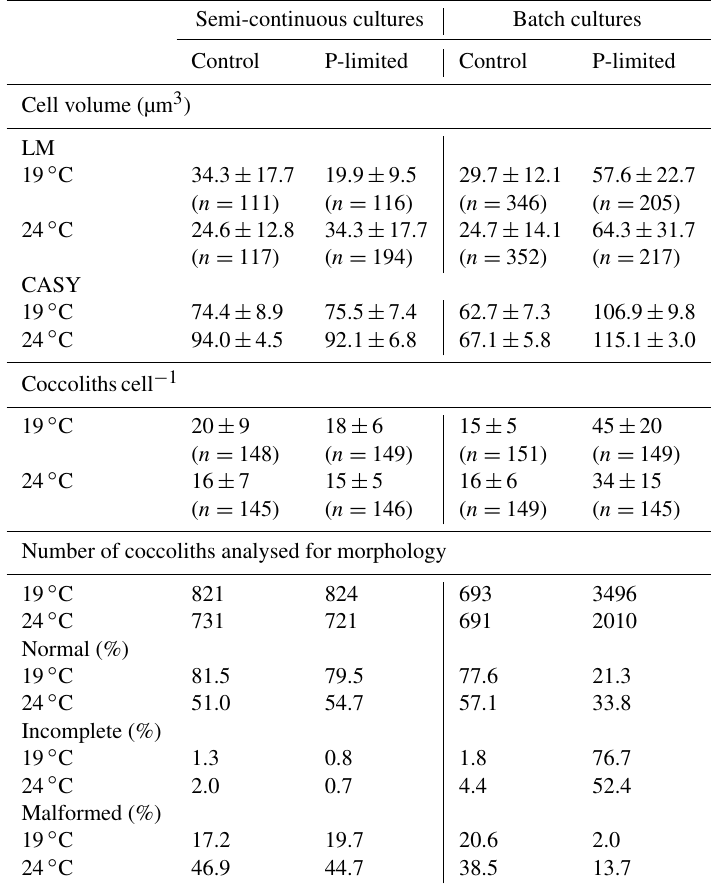
Table 2. Cell volume calculated from LM and CASY measurements at the time of harvest, number of coccoliths cell − 1 and number of coccoliths analysed by SEM and classified into normal, incomplete and malformed coccoliths in semi-continuous and batch control and P-limited cultures of Emiliania huxleyi grown at 19 and 24 ◦ C. The number of cells ( n ) analysed for each measurement is presented as the sum of three replicates, except for CASY cell volume measurements for which n = 3 ± standard